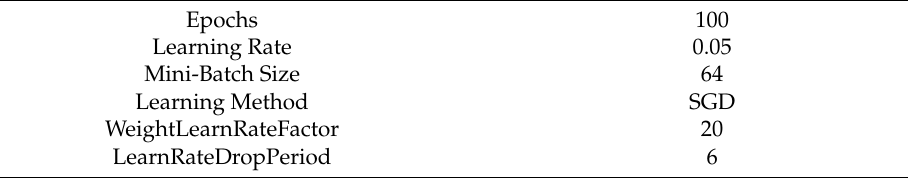
Table 1. Configuration parameters of the modified deep learning models.